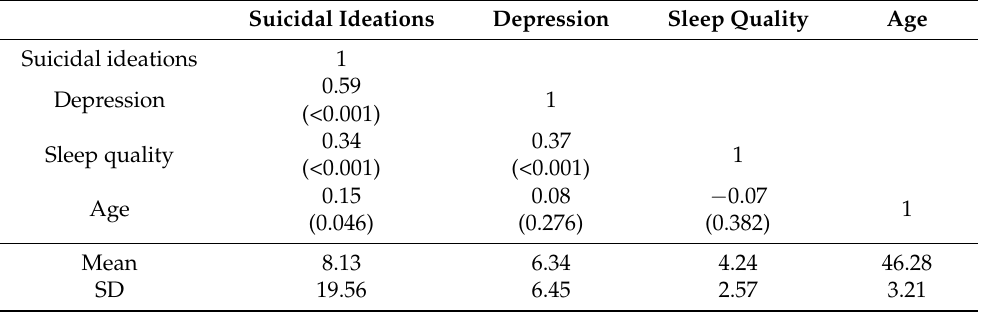
Table 2. Pearson correlations among the suicidal ideations, depression, and sleep quality ( n = 178). Suicidal